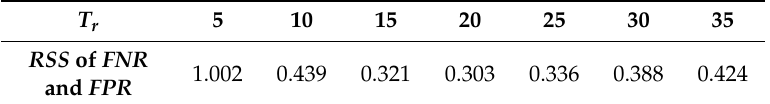
Table 2. Root sum square of FNR and FPR when T r varied from 5 to 35 and m = 300.